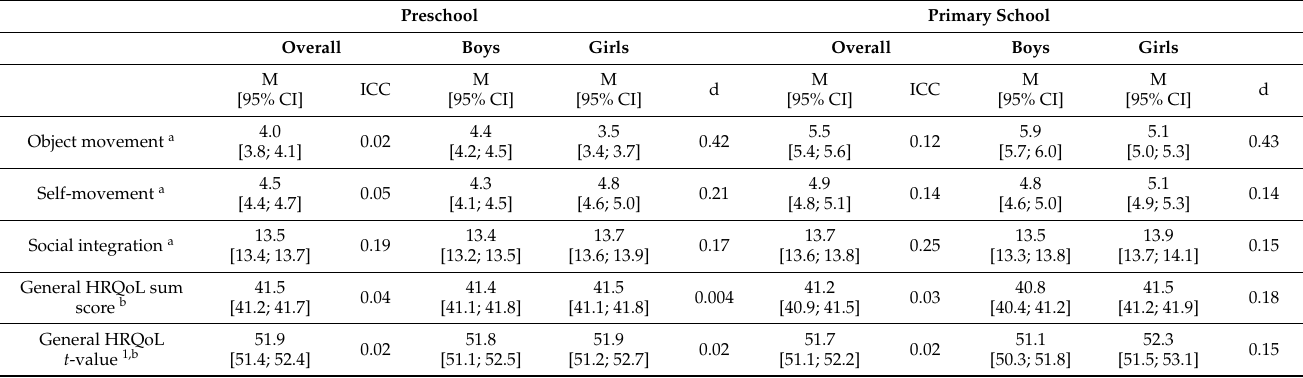
Table 2. Descriptive analyses of sum scores of the motor competency domains, social integration, general HRQoL, and physical